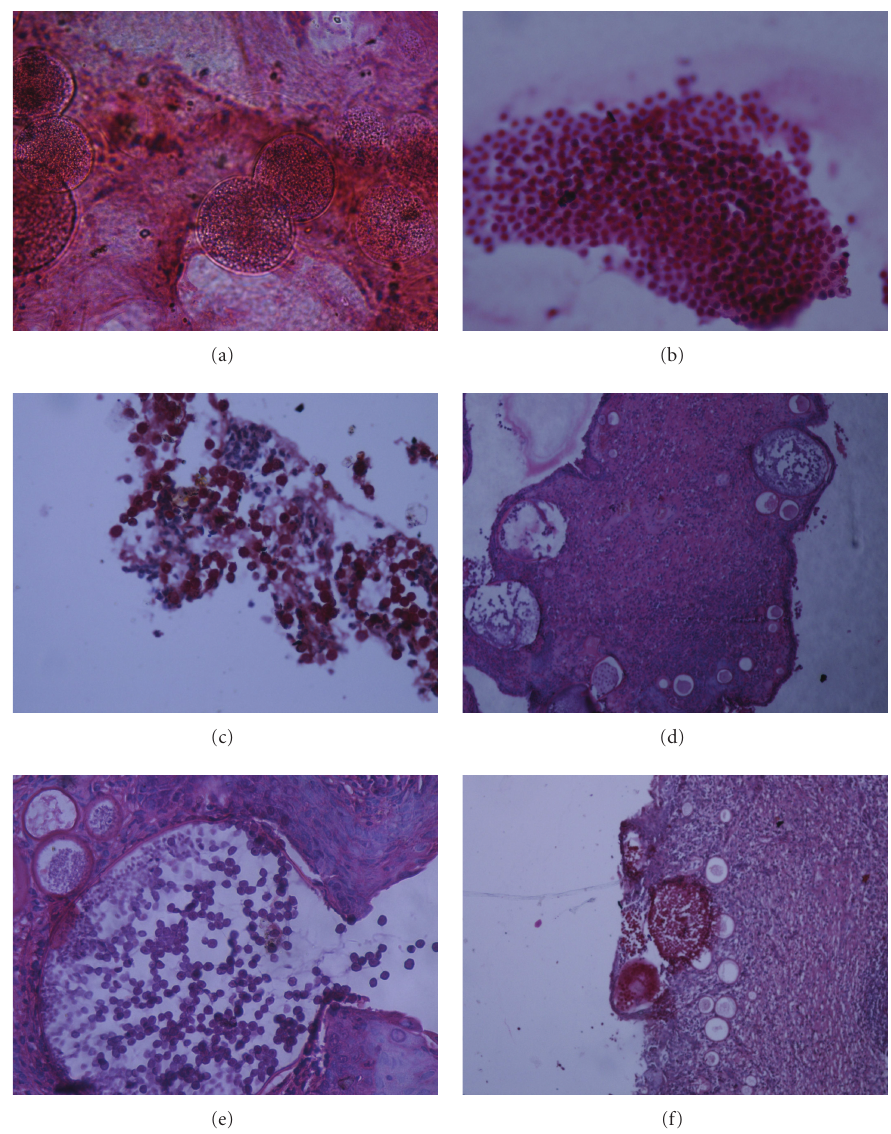
Figure 1: (a) FNA smear showing globular sporangia containing spores (H&E × 400). (b) FNA smear showing isolated spores and inflammatory cells (H&E × 400). (c) PAS positive spores on FNA smear (PAS × 400). (d) Histopathological section showing sporangia and inflammatory cells in a fibrous stroma covered by stratified squamous epithelium (H&E × 100). (e) Ruptured sporangia liberating the spores histopathology section (H&E × 400). (f) PAS positive sporangia and spores on histology (PAS ×